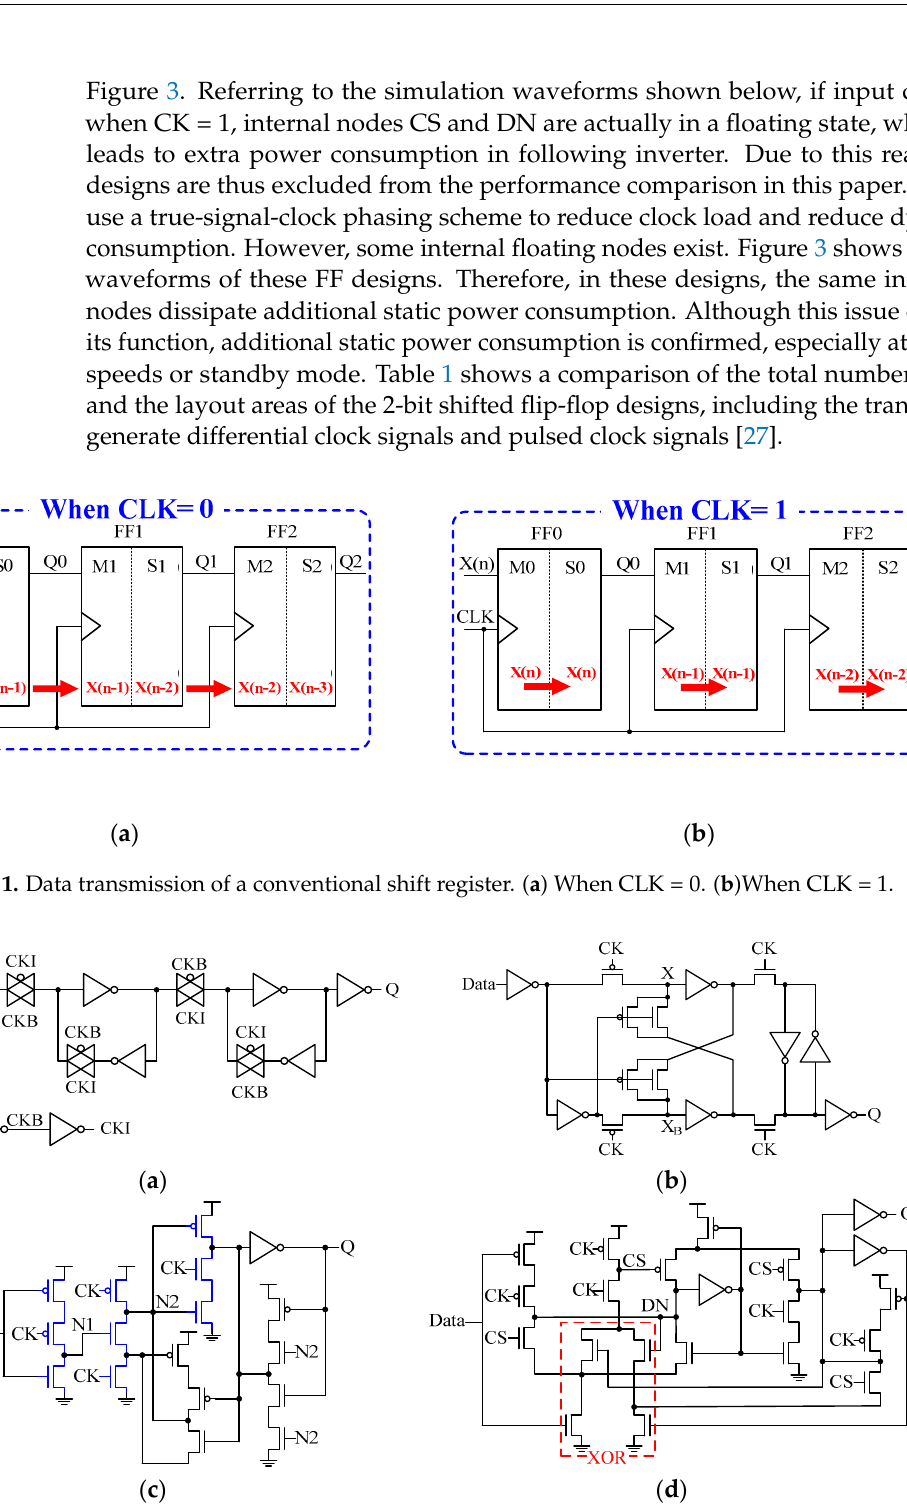
Figure 2. Previous master and slave (MS) latches based flip-flop (FF) designs. ( a ) Transmission gate flip-flop (TGFF). ( b ) Adaptive coupling flip-flop (ACFF) [28]. ( c ) True single-phase clock flip-flop (TSPCFF) [29]. ( d ) Charge sensing flip-flop (CSFF) [30].